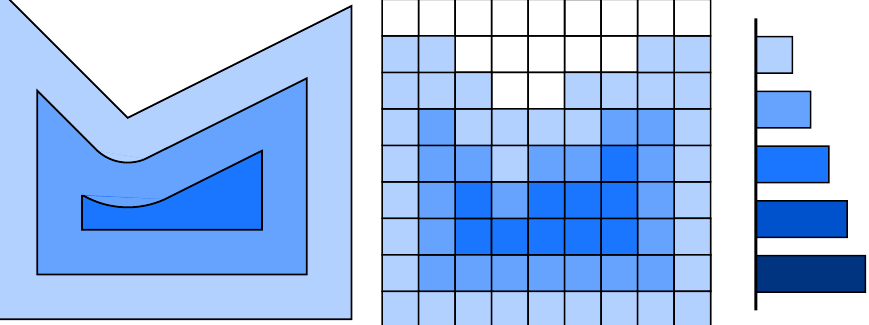
Figure 9. The “shrinking” of a polygon is geometrically called inner constrained δ -annulus. Since the calculation is complicated and numerically not stable ( left ), a simpler approach using cell grids ( right ) is implemented in the